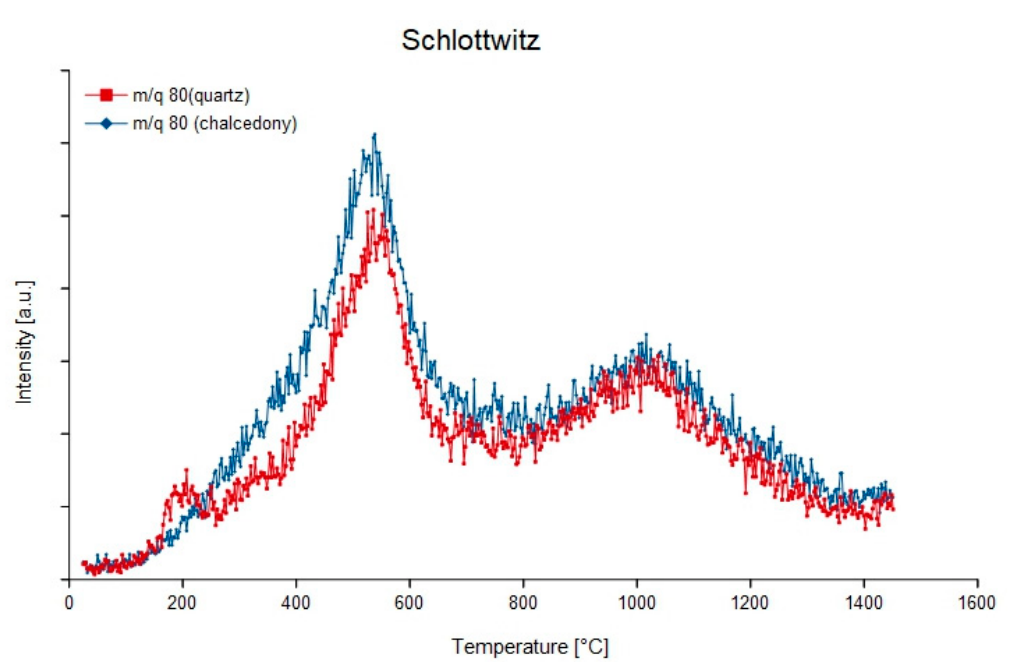
Figure 15. Degassing curves of quartz and chalcedony from the hydrothermal vein agate of Schlottwitz, Germany at mass-charge ratio 80 ( 1 H 232 S 16 O 4 ).